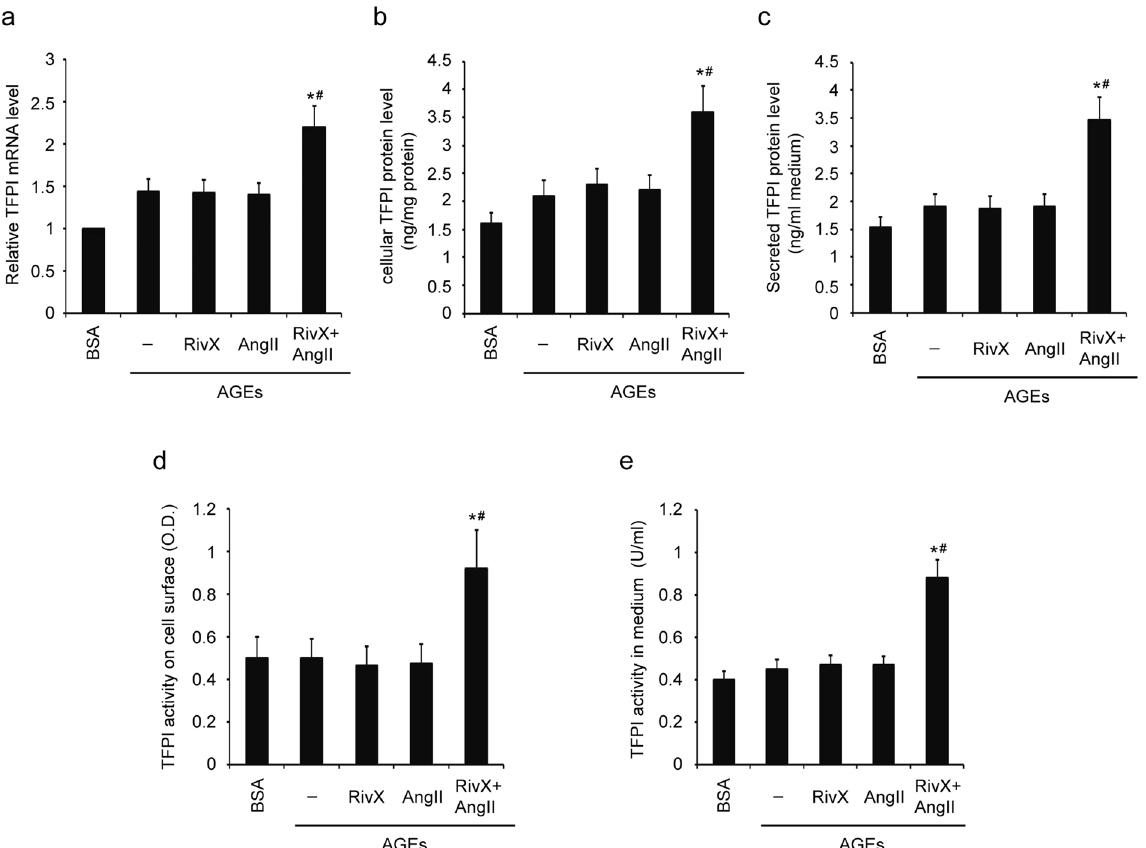
Figure 5. Rivaroxaban promoted TFPI expression and activity in the presence of AngII in HUVECs. HUVECs were pre-incubated with 100 μ g/ml AGE-BSA and non-glycated BSA for 2 h. Cells were then treated with 30 nM rivaroxaban (RivX) or 200 nM AngII for 4 hours. ( a ) TFPI mRNA expression, ( b ) cellular TFPI protein, ( c ) TFPI secretion into the culture medium, ( d ) TFPI activity on the cell surface, and ( e ) TFPI activity in the medium were measured. The bars show the mean ± SEM (n = 4). * P < 0.05 compared with the parallel RivX alone group, and # P < 0.05 compared with the parallel AngII alone